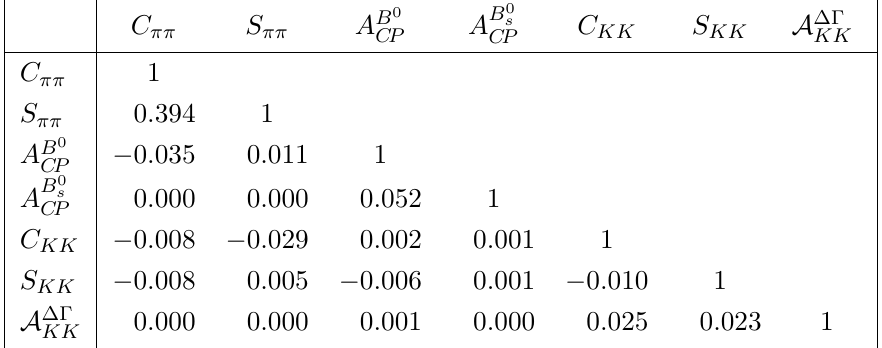
Table 3 . Correlations of statistical uncertainties among the CP -violating parameters.